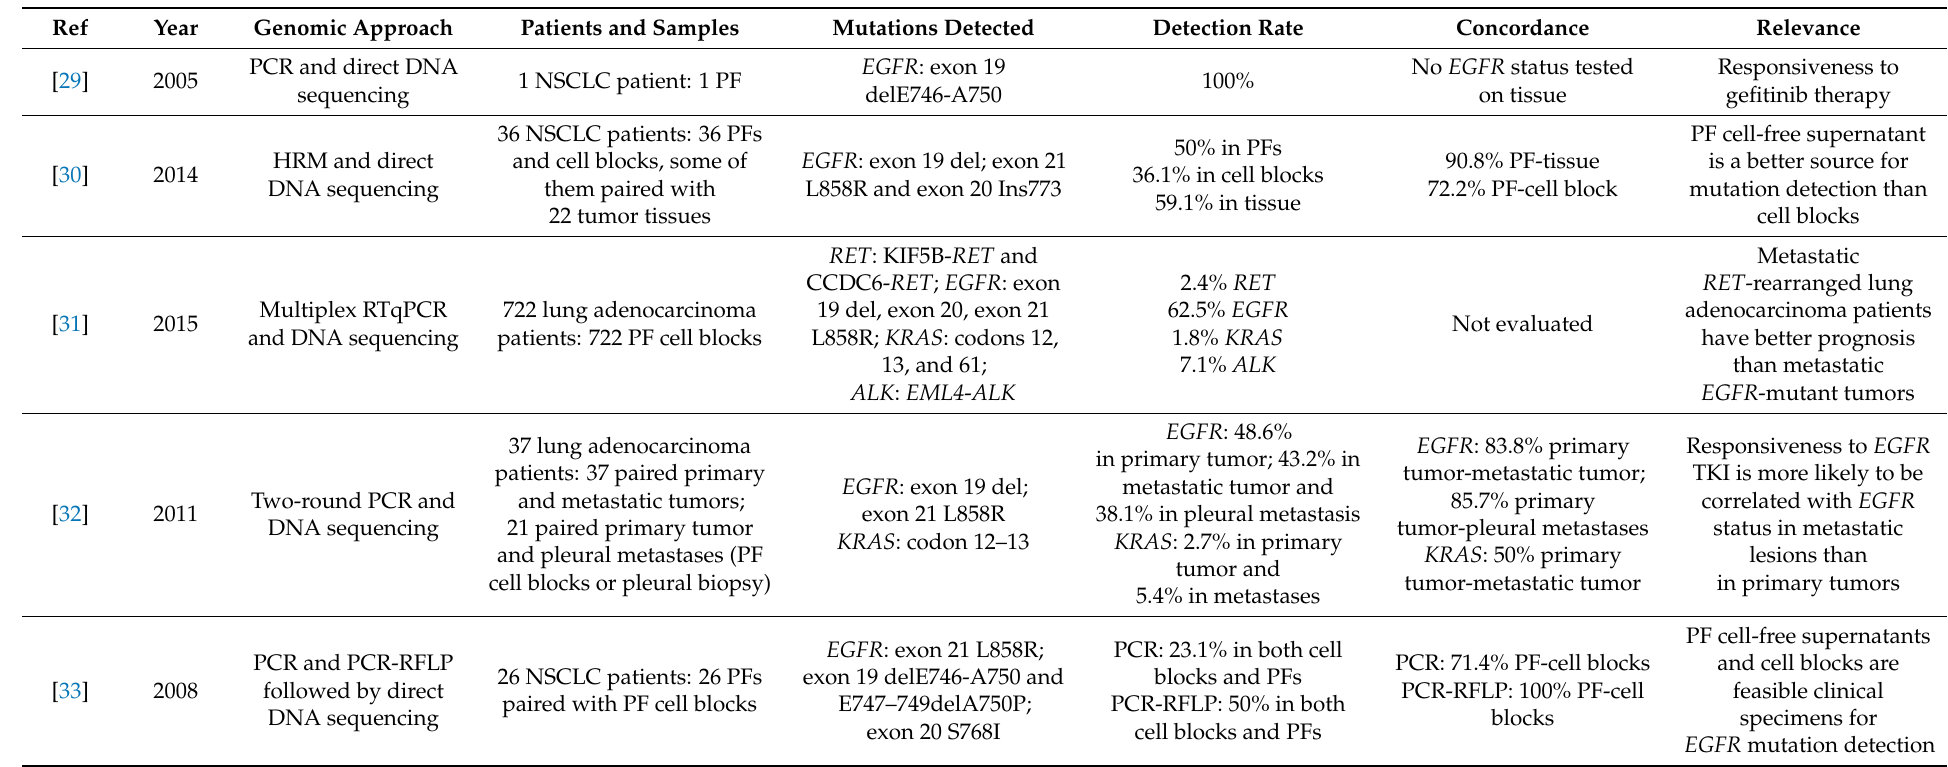
Table 1. Genomic approaches of liquid biopsies on pleural fluid